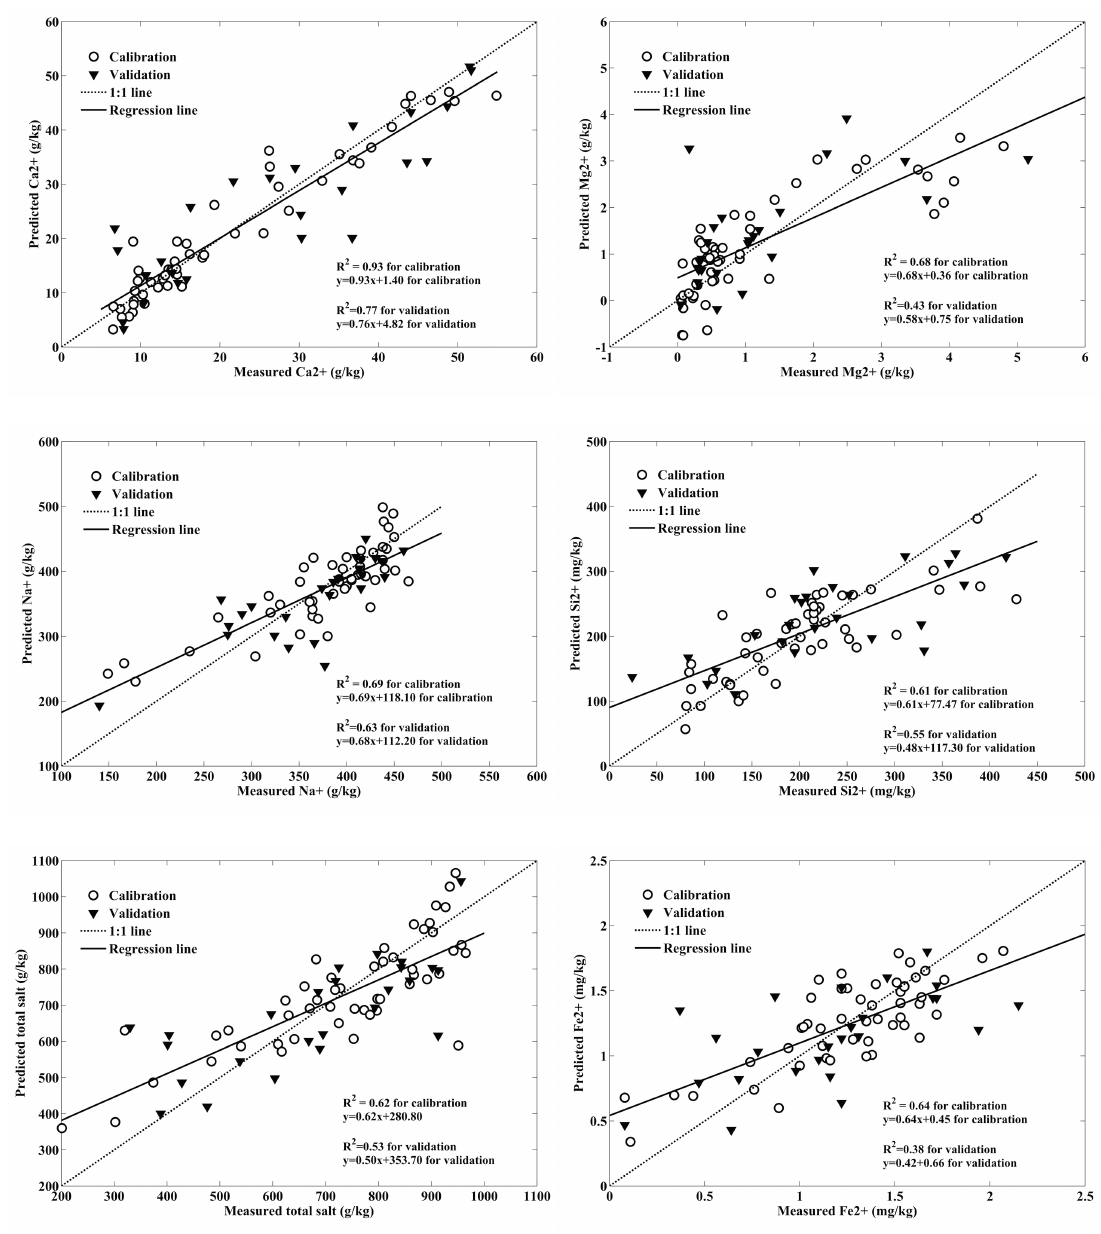
Figure 3. Scatter plots between measured salt crust properties and PLS estimates using simulated Hyperion